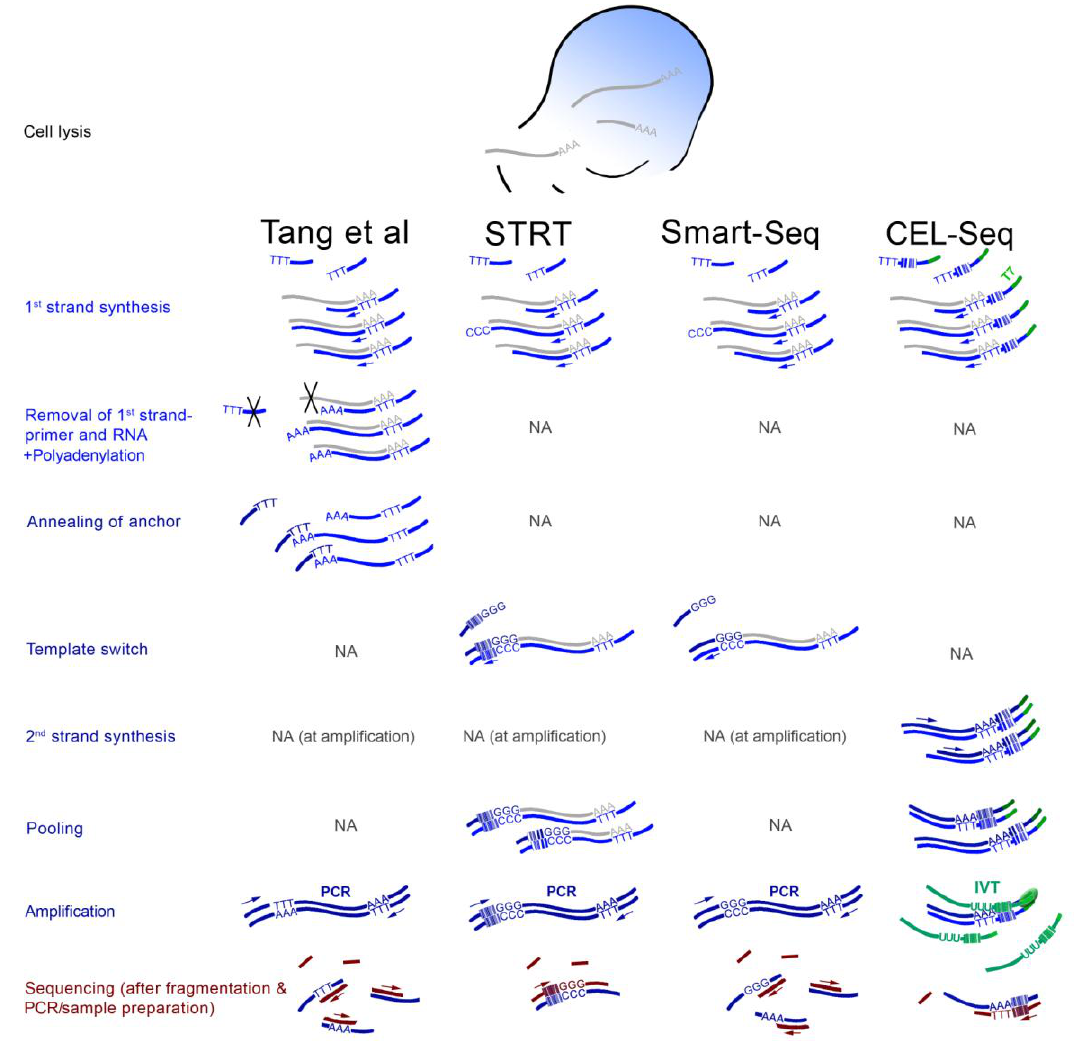
Figure 1. Overview of four scRNA-seq methods. The scheme is a simplification and the focus is the differences between the protocols and the steps that are characteristic to each. The Tang protocol [21,25] includes attachment of adenine nucleotides to the 3' ends of first strands which serve as binding sites for an anchor oligonucleotide, and the RNA and 1st strand primers are removed enzymatically (black crosses). STRT and CEL-seq [23,24,26] include sample pooling based on first strands with barcodes at 5' and 3' regions, respectively, with regards to the original transcripts. CEL-seq uses IVT as first amplification step, which requires direct RNA adapter ligation followed by a second reverse transcription during sequencing sample preparation. Smart-Seq [27] is a simplification of STRT without barcoding. All PCRs are primed from sequences introduced by the flanking oligonucleotides. Arrows indicate primer-initiated DNA polymerization. Nucleotide stretches (such as AAA or TTT) are for illustration only and do not reflect the actual number of nucleotides. The color-coding was chosen to roughly discriminate between the crucial 1 st strand-related steps (light blue), protocol-specific steps (dark blue), and the more interchangeable sequencing sample preparation